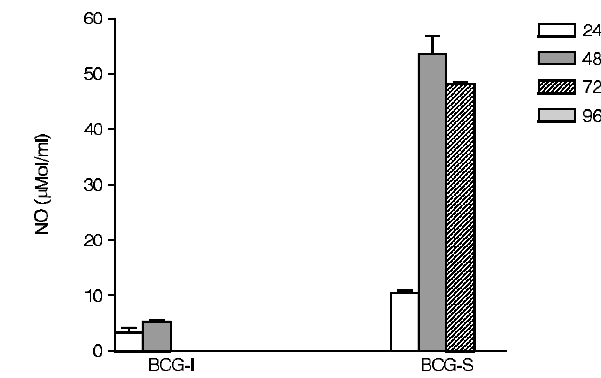
FIG. 3. Nitric oxide (NO) production. Mice were sacrificed and their peritoneal macrophages were collected. Peritoneal macrophages were stimulated in vitro as described above. NO levels were detected by Griess colorimetric reaction. Each point represents the values of samples from five experiments ± standard deviation in different groups of five mice.